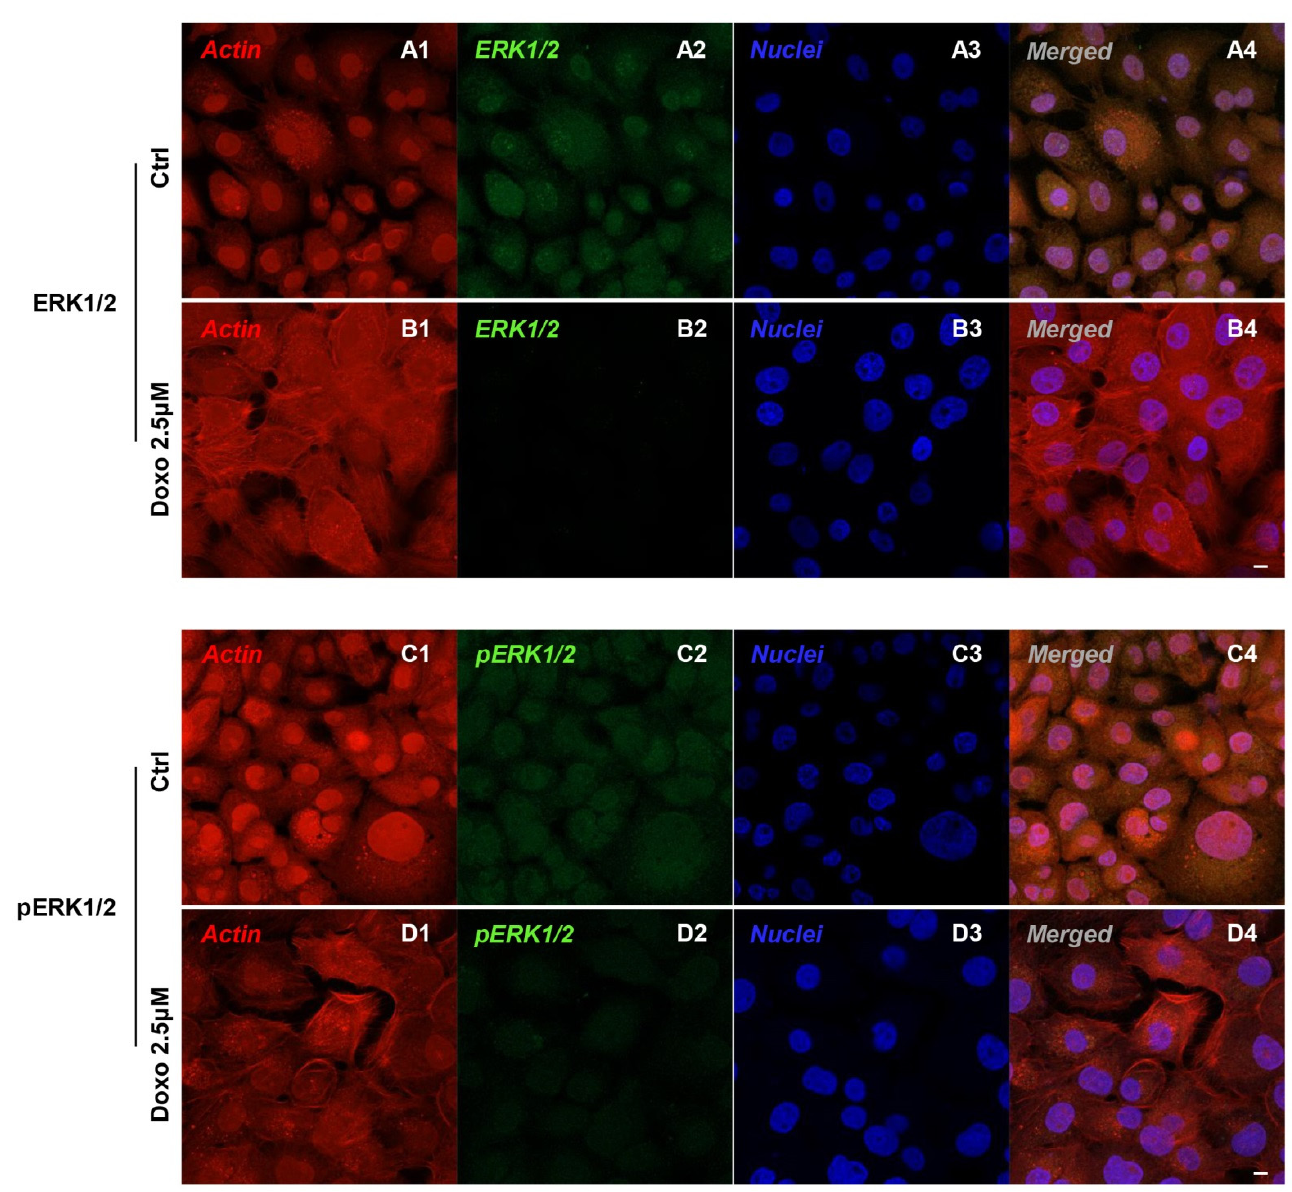
Figure 5. Confocal microscopic analysis on the expression of ERK 1/2 and pERK 1/2 in Cal-27cell lines. Expression of ERK 1/2 and pERK 1/2 analyzed by confocal microscopy in untreated cells (CTRL) ( A1 – A4 , C1 – C4 ); expression of ERK 1/2 and pERK 1/2 analyzed by confocal microscopy in Cal-27 treated with Doxo 2.5 µM ( B1 – B4 , D1 – D4 ). Red fluorescence: cytoskeleton actin. Green fluorescence: ERK 1/2 and pERK 1/2. Blue fluorescence: cell nuclei. Scale bar: 20 µm.